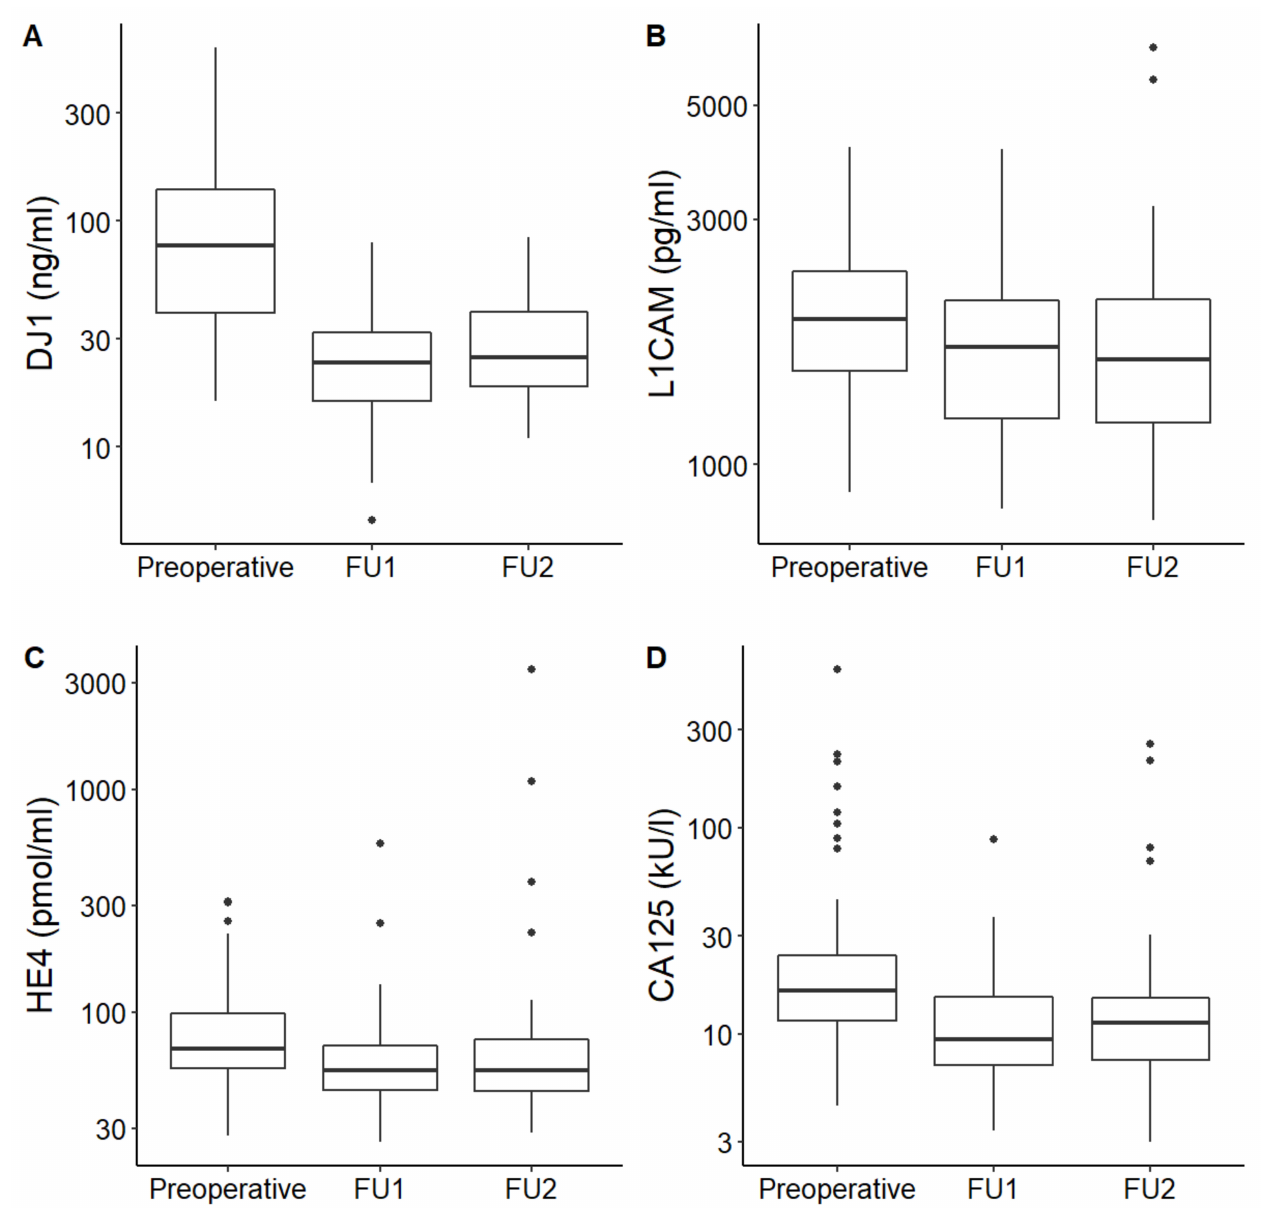
Figure 1. DJ-1 ( A ), L1CAM ( B ), HE4 ( C ) and CA125 ( D ) levels at three different time points: before surgery (preoperative), first follow-up collection (FU1) and second follow-up collection